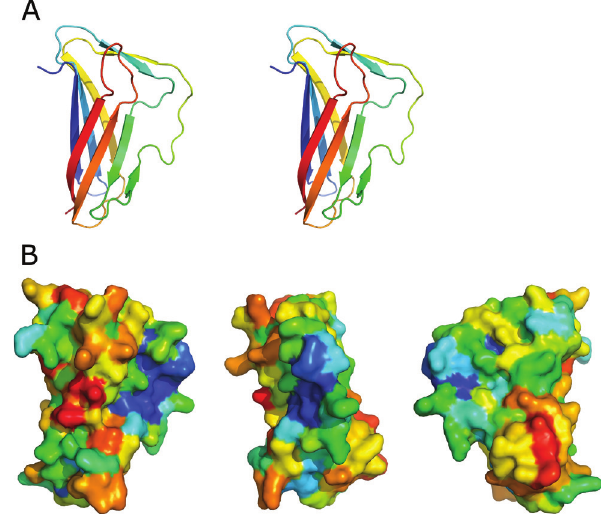
Figure 1. Overall structure of Intracellular Protease Inhibitor (IPI) reveal a wedge shape with a conserved surface. A ) Stereo cartoon representation of IPI coloured from blue to red, N- to C-terminus. Protruding loops on the right hand side form a wedge shape. B ) Sequence conservation amongst known homologues mapped to the protein surface with red indicating high conservation and blue low. The left panel shows IPI in the same orientation as in A ), the other two show the results of successive 90 degree rotations about a vertical axis so that the wedge is seen end-on in the centre panel and the right panel shows the opposite face to the left